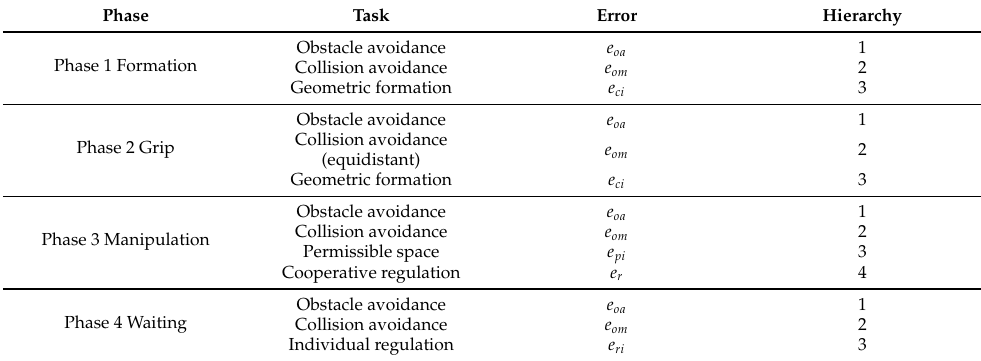
Table 2. Tasks to accomplish in each